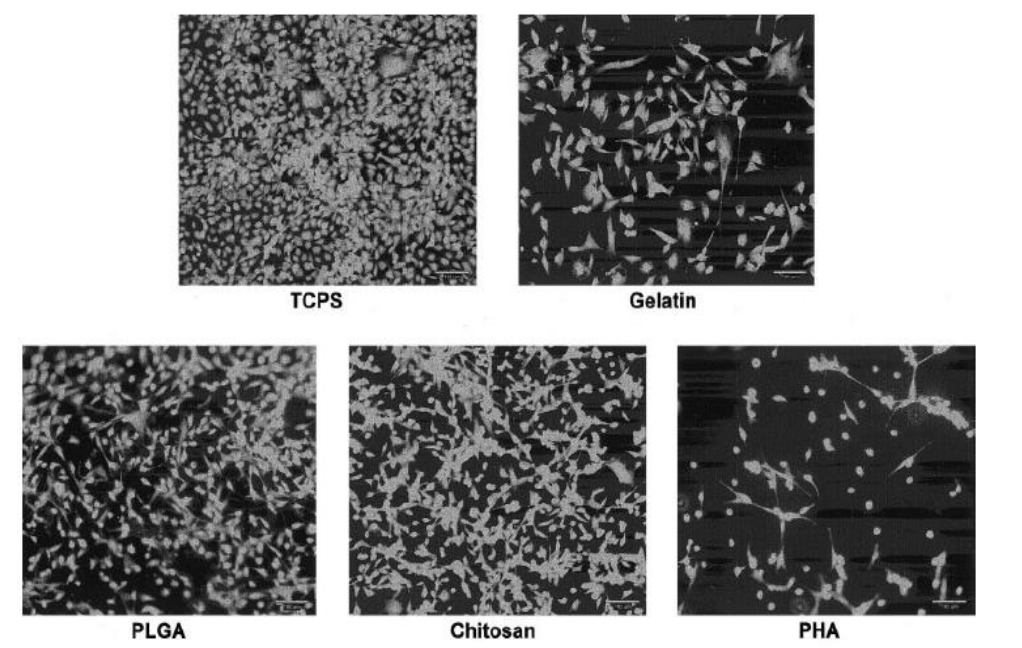
Figure 9. Fluorescence micrographs of VECs seeded onto substrates (bar = 100 µ m). Reprinted with permission from ref. [164]. Copyright 2003, Wiley Periodicals.